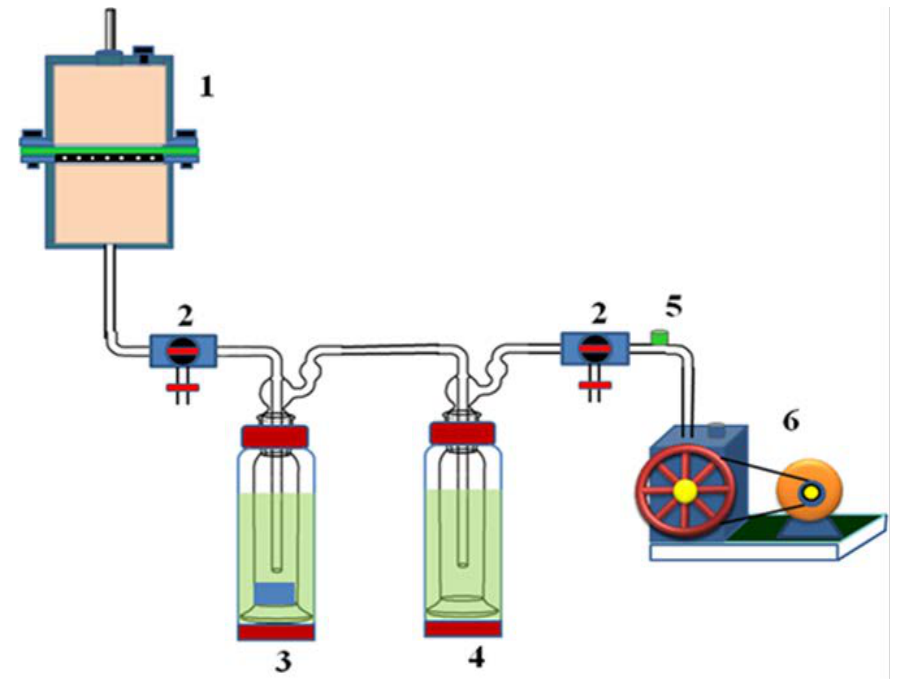
Figure 10. Schematic representation of the pervaporation apparatus: ( 1 ) pervaporation cell; ( 2 ) vacuum control valves; ( 3 ) permeate cold trap; ( 4 ) moisture cold trap; ( 5 ) pressure sensor; ( 6 ) vacuum pump.